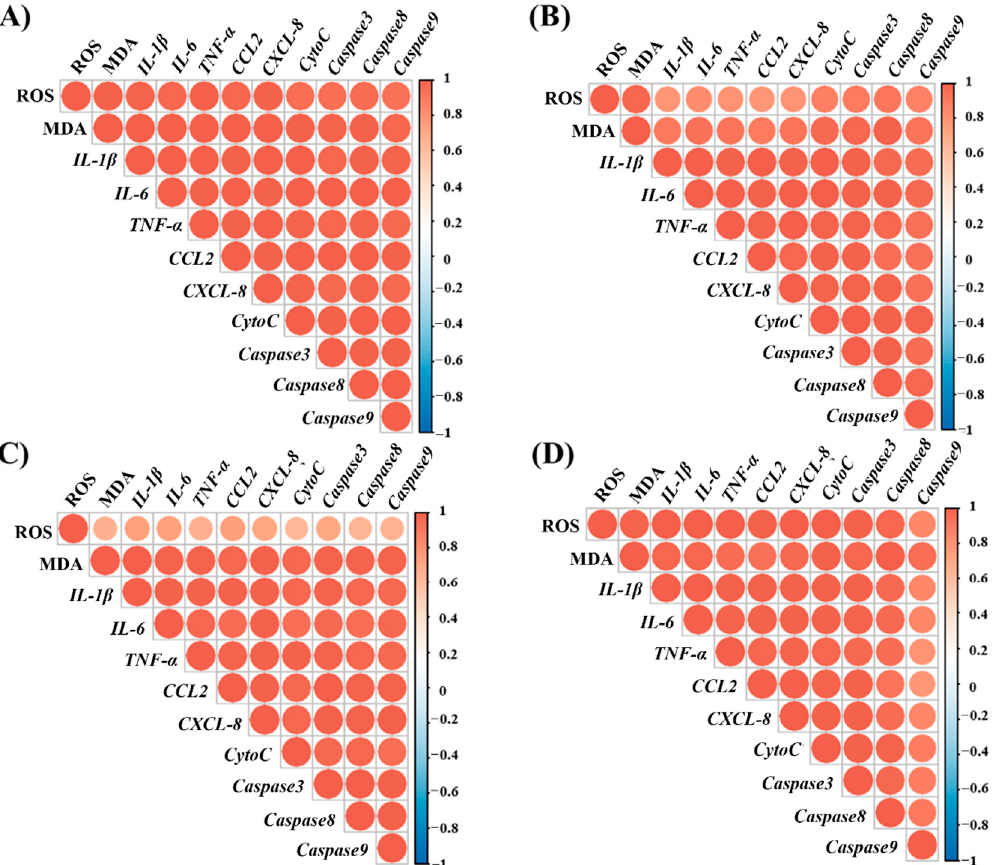
Figure 5. Correlation between oxidative stress indicators ROS, MDA, and inflammatory factors IL-1 β , IL-6 , TNF- α , CCL2 , CXCL8, and CytoC, and mitochondrial apoptosis-related indicators Caspase 3 , Caspase 8, and Caspase 9 in TFs-treated RTE cells exposed to ZnO-NPs-30 nm ( A ), ZnO-NPs-90 nm ( B ), EGCG-treated RTE cells exposed to ZnO-NPs-30 nm ( C ), and ZnO-NPs-90 nm ( D ).